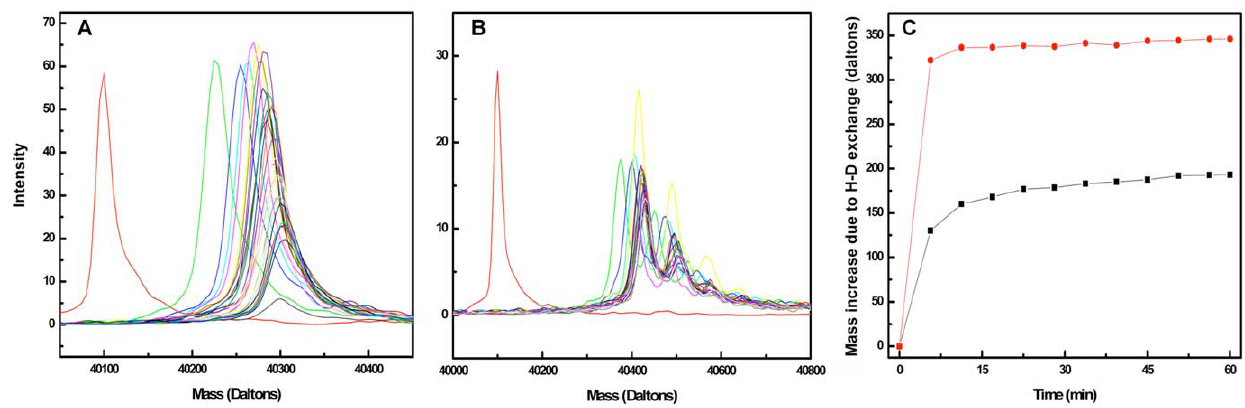
Figure 6. Nucleotide-free G a i1 bound to Ric-8A exhibits rapid hydrogen/deuterium exchange kinetics relative to the G a i1 N GDP complex. (A) Mass distribution for G a i1 N GDP measured at fixed time points (see panel C) after dilution into D 2 O; the mass distribution at the zero time point, before exchange was initiated, corresponds to the red peak centered at 40.1 kDa. The average of the G a i1 mass distribution increases as H/D exchange reaction proceeds. (B) Mass distribution for G a i1[ ] in complex with Ric-8A measured at fixed time points after dilution into D 2 O; note that the G a i1[ ] mass distribution becomes multimodal as the H/D exchange reaction proceeds. (C) The increase in mass (Da), determined at the centroid of the mass distribution of G a i1 N GDP (black squares) and G a i1[ ] derived from the complex with Ric-8A (red circles) is plotted as a function of